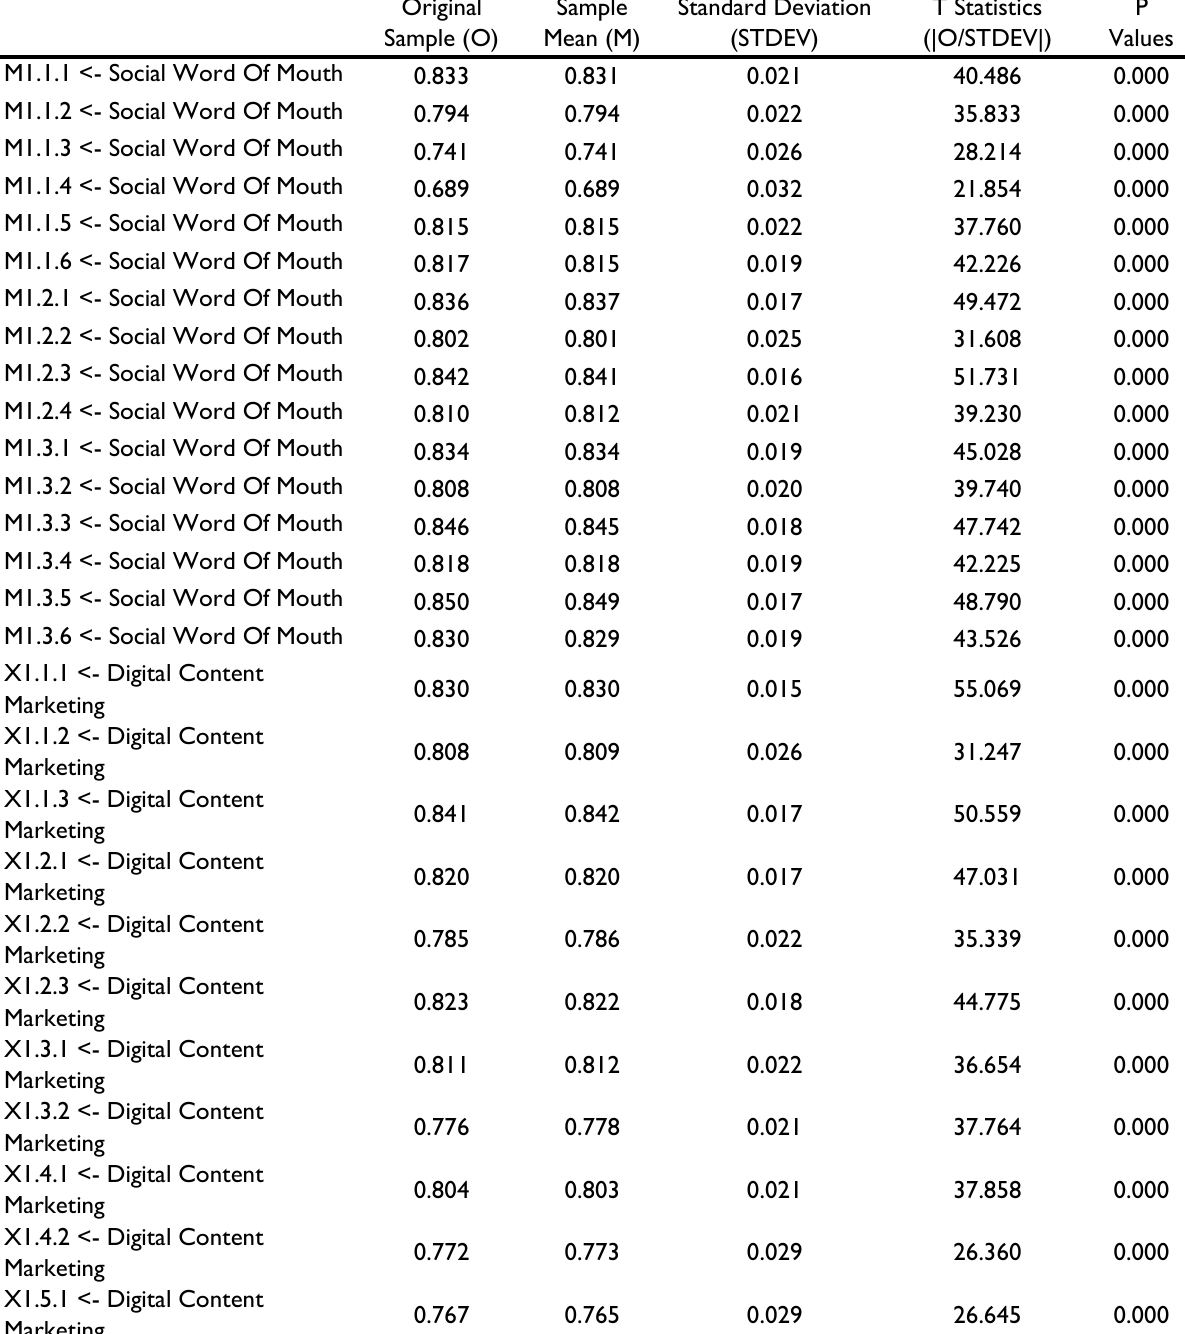
Table 4. Inner Model Evaluation